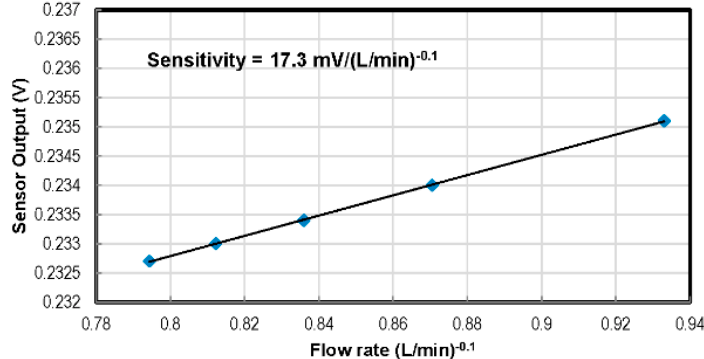
Figure 15. Linearized calibration curve of the aluminium hot film-based flow rate sensor operated in constant current mode at 40 mA.